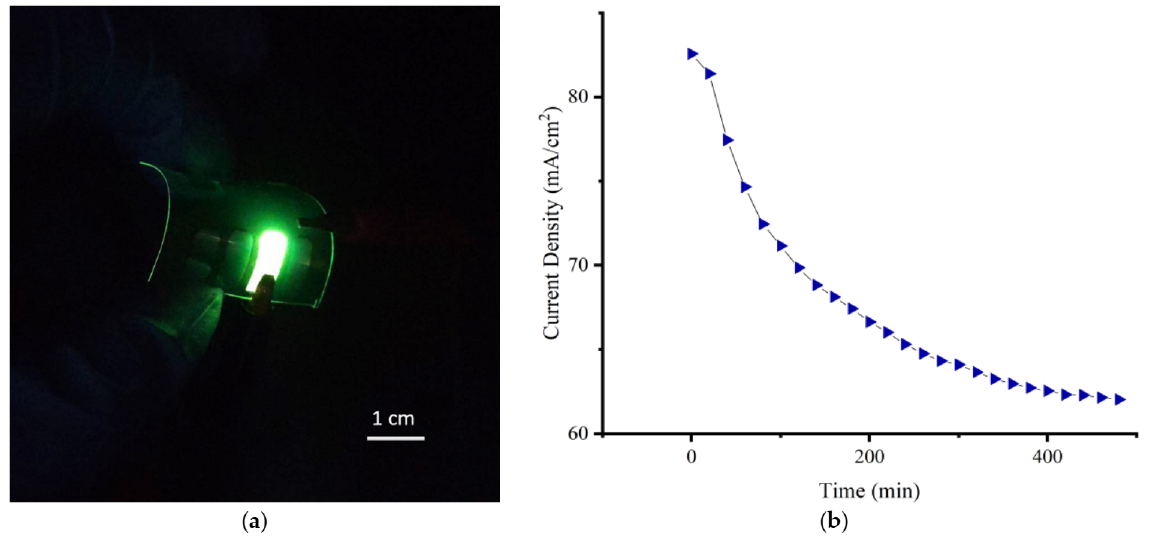
Figure 9. The real picture of flexible green OLED and its stability measurement results: ( a ) the real picture of light emission; ( b ) time–current density